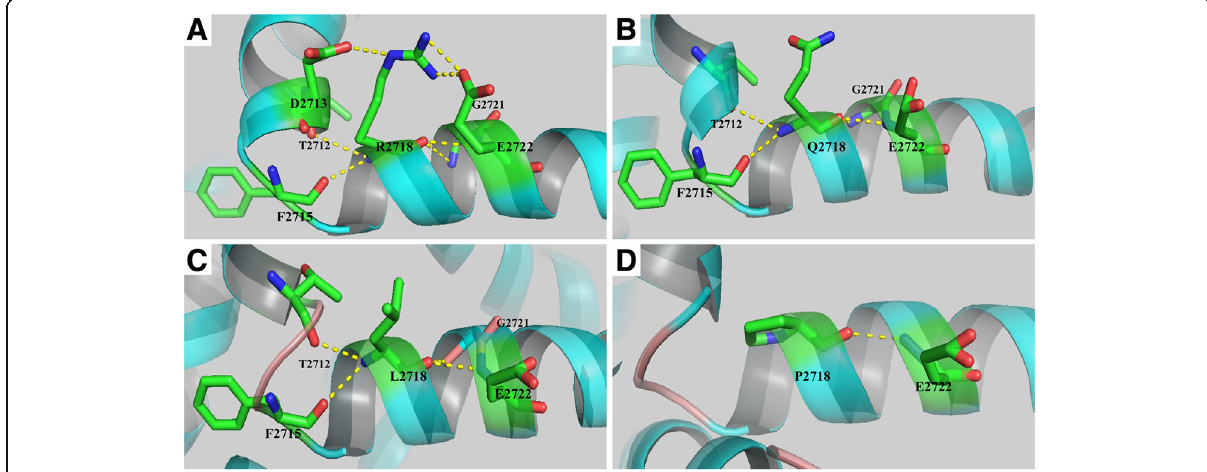
Fig. 6 Three substitutions in position 2718 of PIEZO2 are simulated by means of SWISS-MODEL and are represented with Ribbon. a The wild-type amino acid at position 2718 is depicted, with H-bonds shown by yellow dashed lines. b The p.R2718Q substitution maintains the most parts of H- bonding interactions. c Leucine tends to lose H-bond with D2713, and the nearby α -helical structure is disrupted. d Substitution with proline eliminates most of the H-bonds with neighboring amino acids